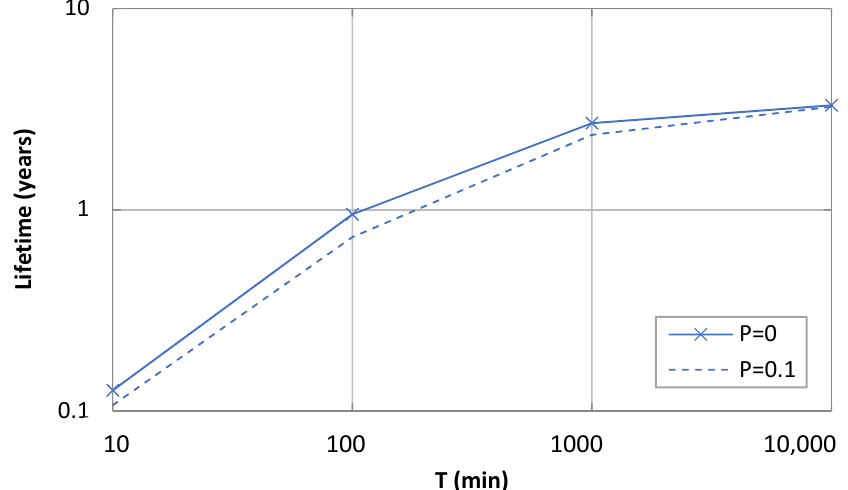
Figure 9. Lifetime of a 2400 mAh-battery-enabled device as a function of T .